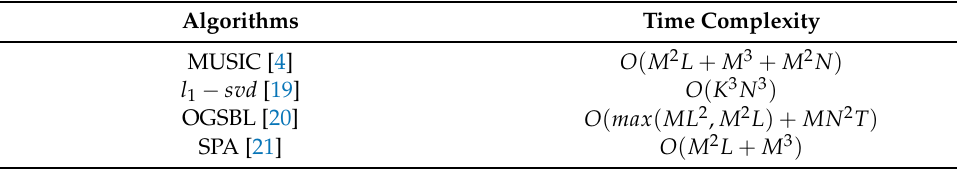
Table 1. The computational complexity of DOA estimation algorithms.